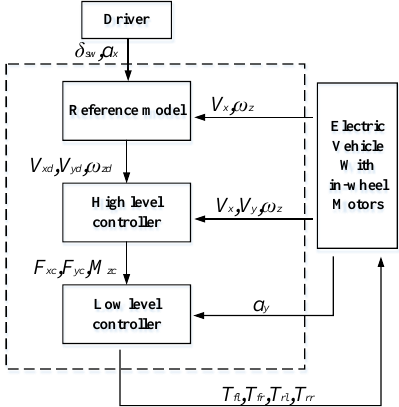
Figure 6. The control block diagram of the proposed controller.